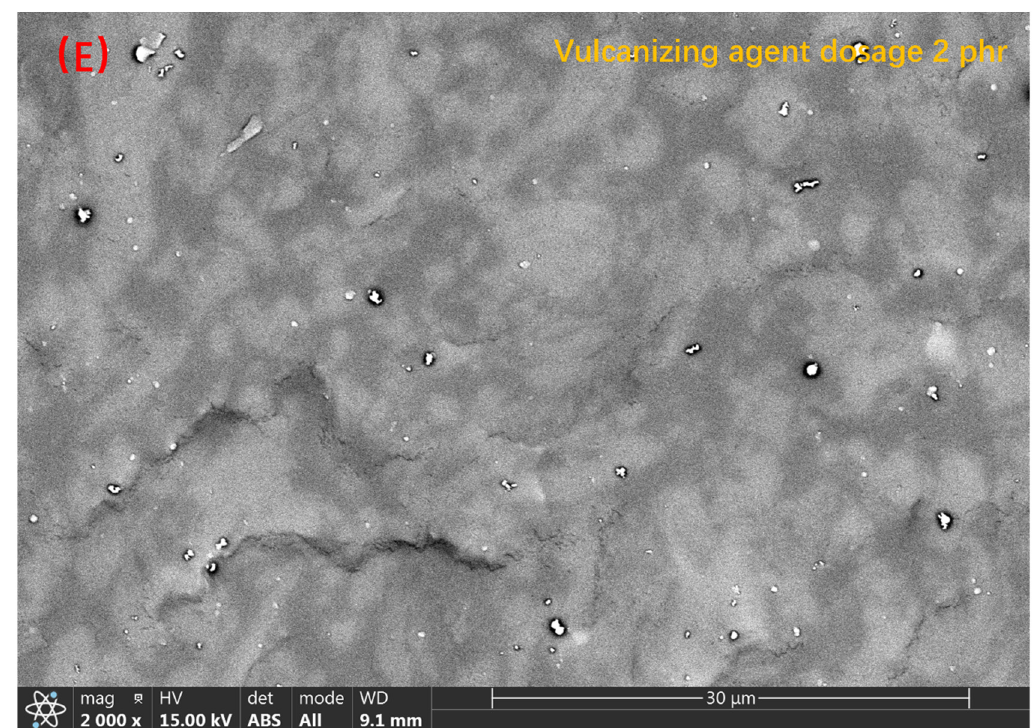
Figure 5. Backscattered electron images of samples 1–5 (Figures A – E correspond to samples 1–5, respectively).